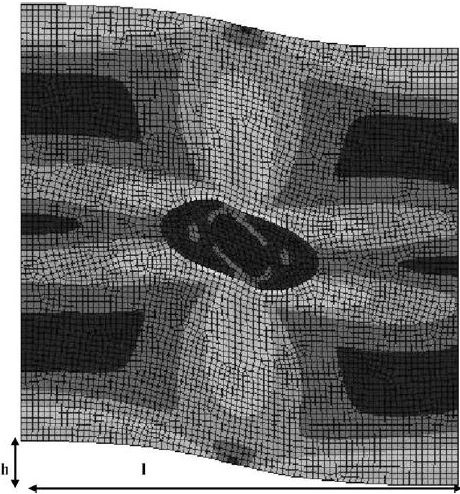
Figure 46. Initial imperfection magnitude h / l [43]. F igure 46. Initial imperfection magnitude